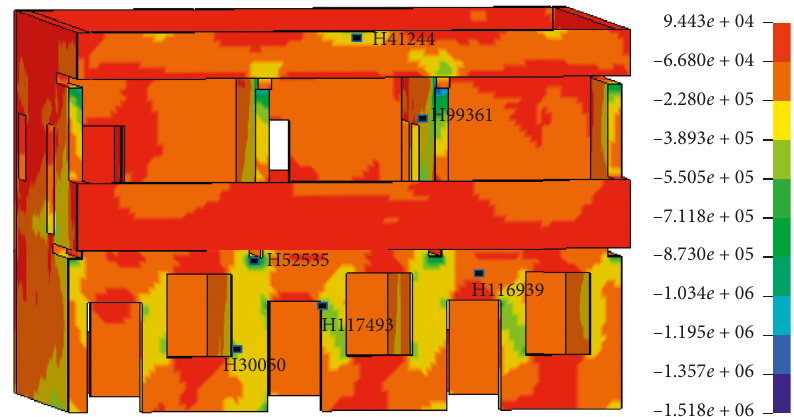
Figure 20: PCS contour of the structure ( t � 0.058s) (unit: Pa).